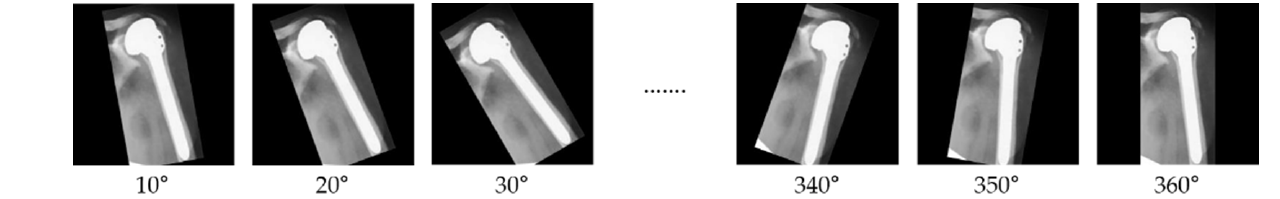
Figure 3. Examples of rotational invariant augmentation (RIA).